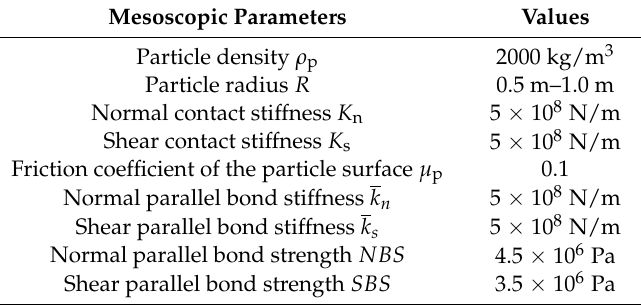
Figure 13. A rock slope simulated by DEM. Table 2. The mesoscopic parameters of the example.